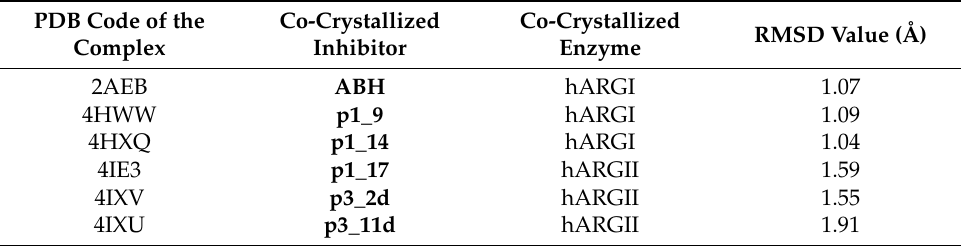
Table 3. Docking accuracy of compounds with a reference in